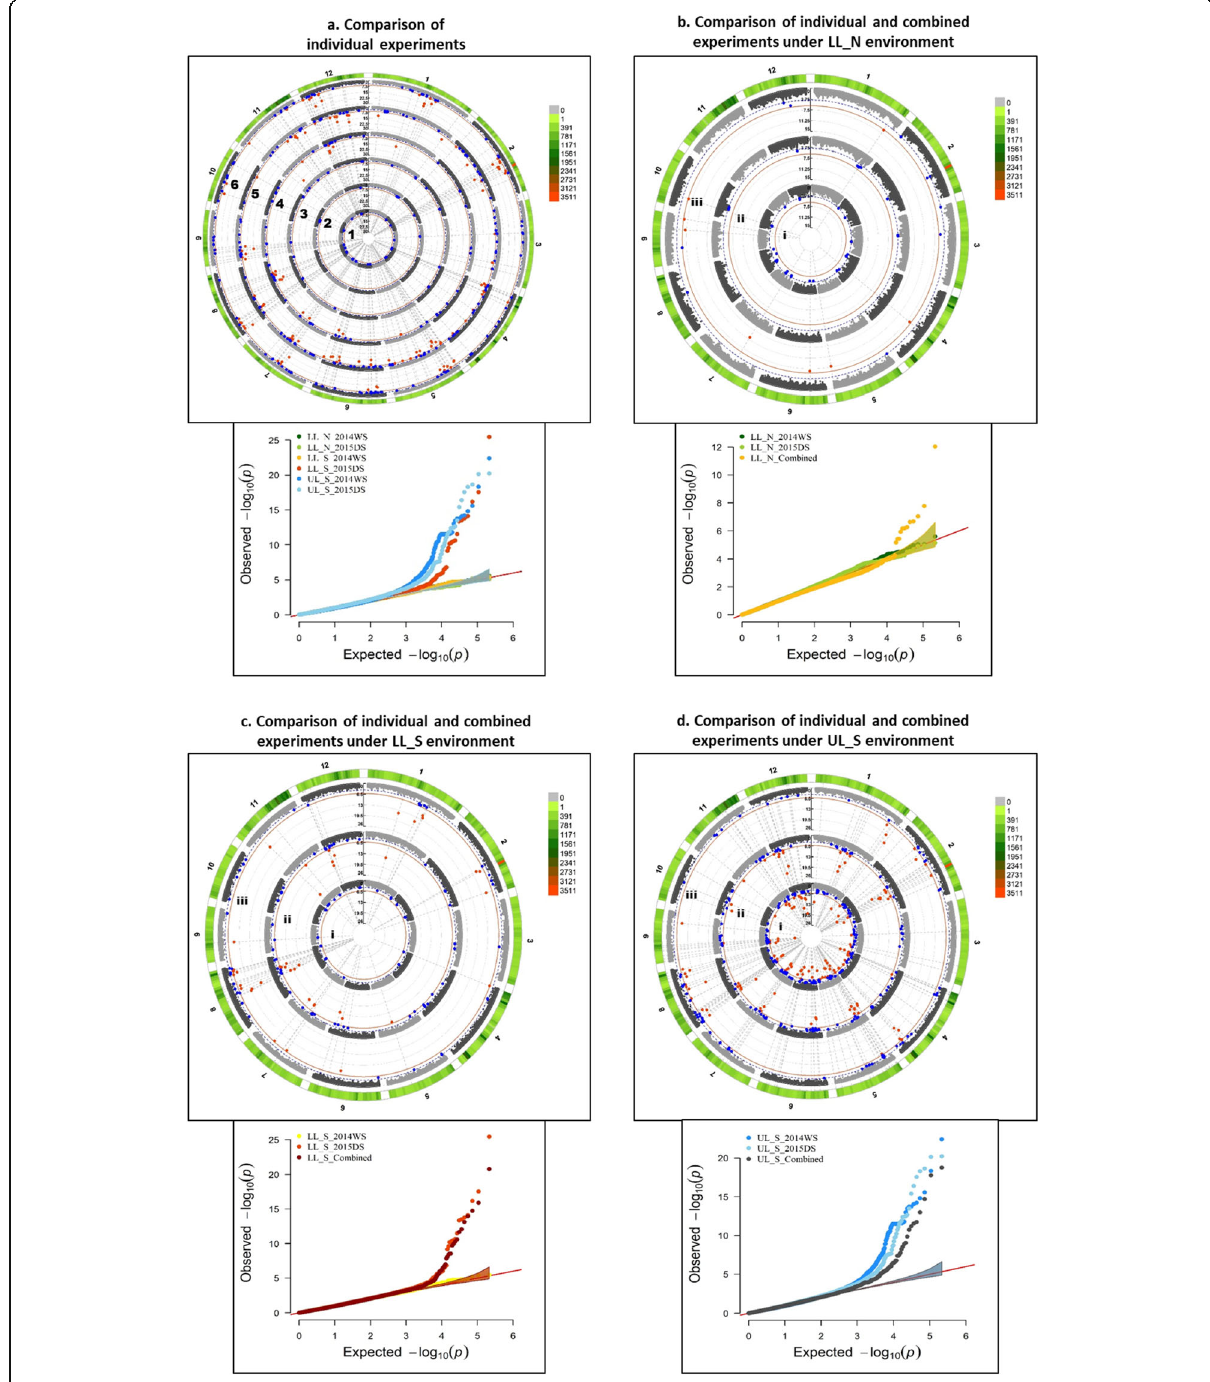
Fig. 6 Circular manhattan plot and qq plot for Grain yield (GY)- a. each of the six experiments (from centre of the plot- 1. lowland non-stress 2014WS (LL_N_WS); 2. lowland non-stress 2015DS (LL_N_DS); 3. lowland stress 2014WS (LL-S_WS); 4. lowland stress 2015DS (LL_S_DS); 5. upland stress 2014WS (UL_S_WS) and 6. upland stress 2015DS (UL_S_DS) for p -values obtained-using Farm-CPU method at two significance thresholds of 1e-4 (blue) and 1e-6 (red). The outermost ring depicts the SNP distribution in the 215,250 SNP working set. Individual experimental results are compared to the combined analysis for each of the three environments- b. LL_N, c . LL_S and d . UL_S, to detect seasonal variation between WS and DS, from centre of the plot-i. WS, ii. DS and iii. Combined